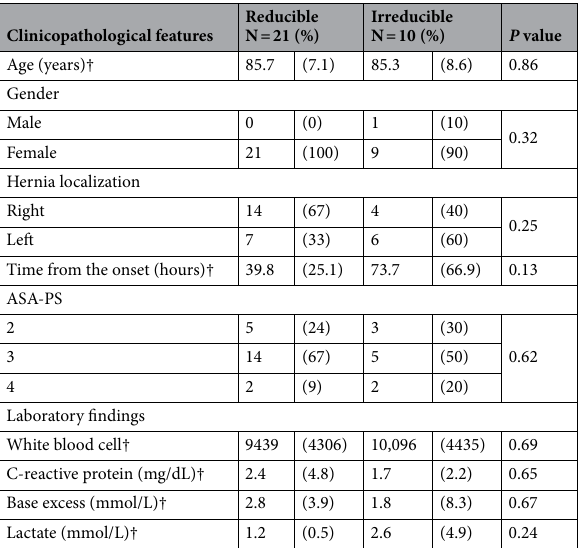
Table 3. Patient characteristics of reducible and irreducible cases. Patients who avoided manual reduction were not included. *Statistical significance. Student’s t test was used for age, time, and laboratory findings— Fisher’s exact test was used for other parameters. Values in parentheses are percentages unless indicated otherwise † values are mean (SD).